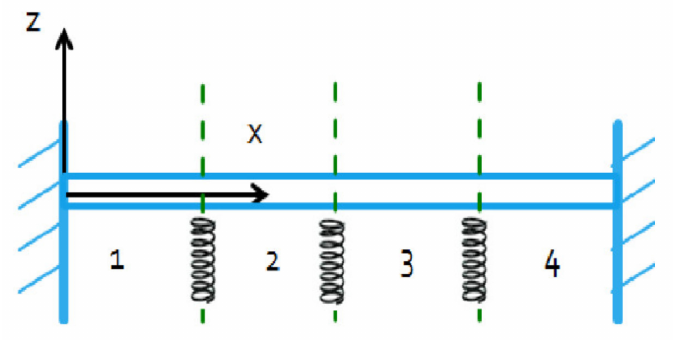
Figure 19. The clamped-clamped beam model supported by linear springs of [7].